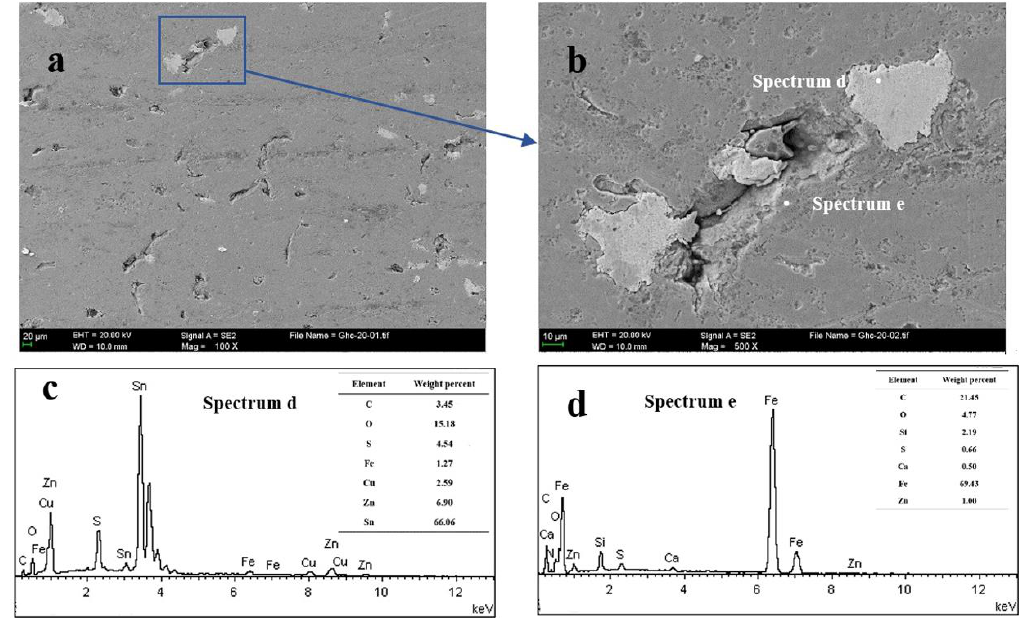
Figure 8. Surface topography ( a ), enlarged area topography ( b ) and position b ( c ) and position c ( d ) element contents of the cylinder liner matched with Cr coated piston ring.